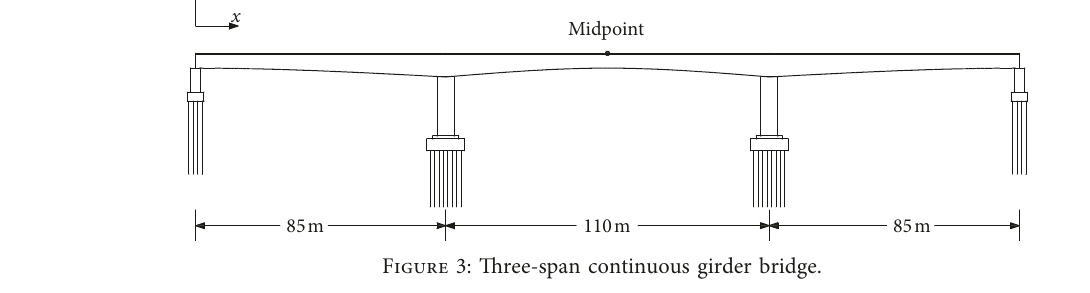
Figure 3: Three-span continuous girder bridge.